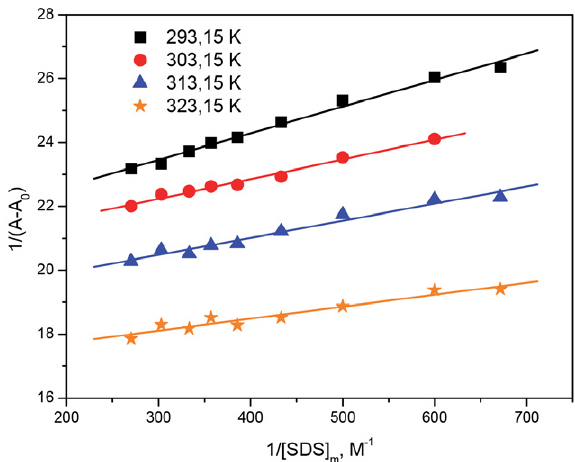
Figure 5. Plot of 1/(A-A 0 ) versus 1/[SDS] m for the interaction of quinizarin with SDS micelles at various temperatures.